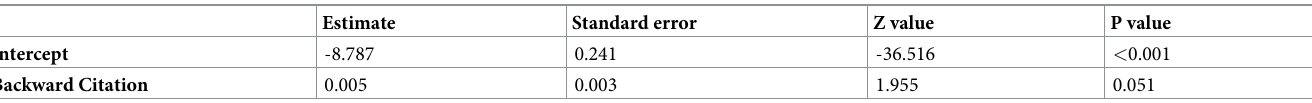
Table 4. Fitted zero-inflation model (binomial with logit